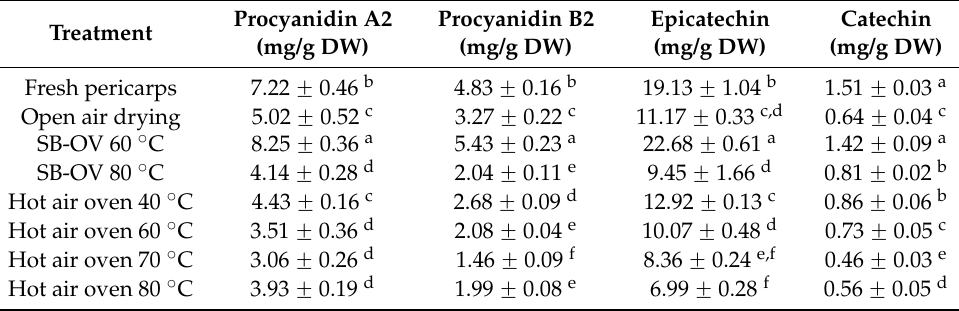
Table 2. Effect of treatments on major procyanidins of litchi